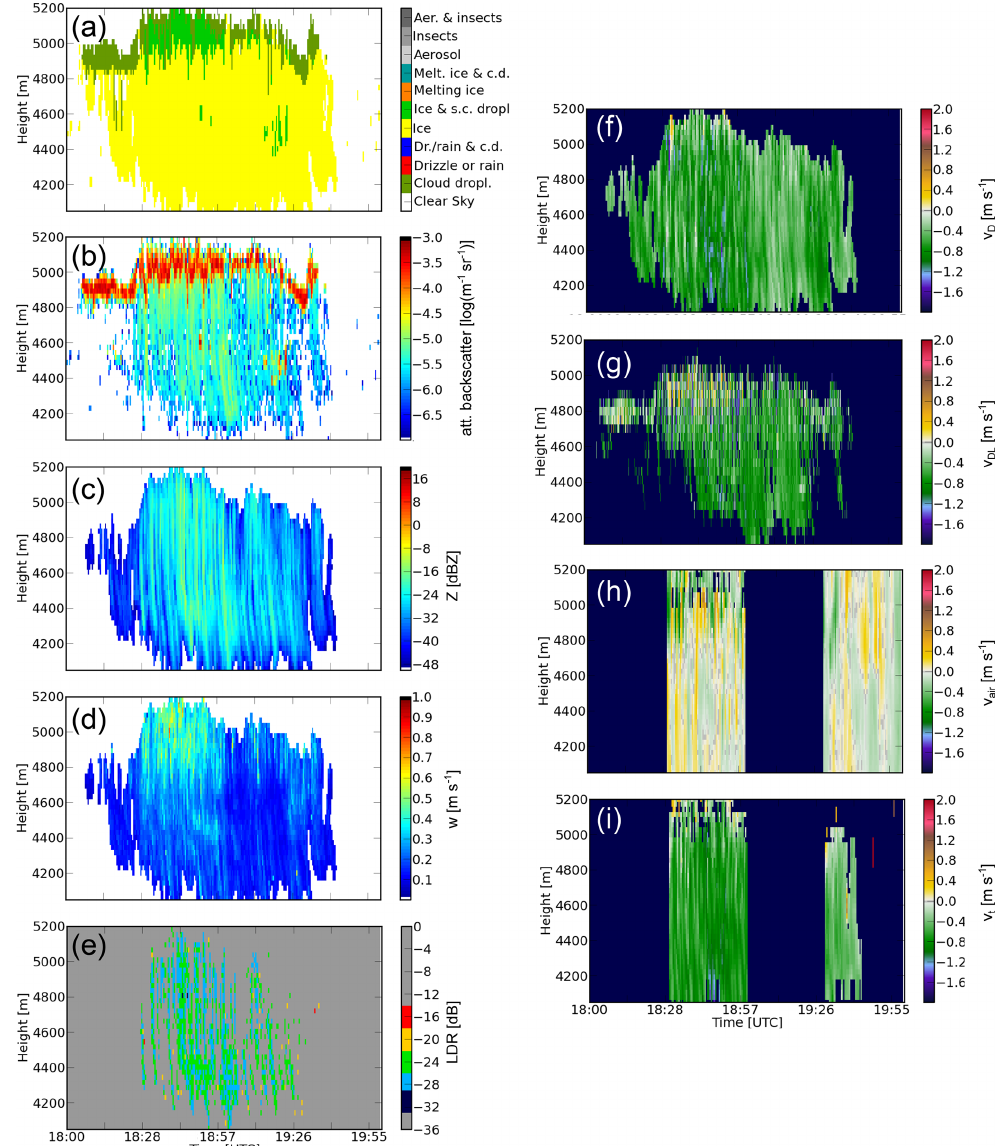
Figure 2. (a) Cloudnet target classification, (b) attenuated backscatter from lidar at the 1064nm wavelength, (c) CR reflectivity Z , (d) CR Doppler spectral width w , (e) CR linear depolarization ratio (LDR), (f) CR Doppler velocity v D , (g) Doppler lidar Doppler velocity v DL , (h) vertical air motions as measured with the RWP v air and (i) reflectivity-weighted terminal fall velocity v t are shown for a mixed-phase cloud layer observed on 11 June 2015 at Lindenberg. v t and v air are only available in 30min intervals because vertical and horizontal wind measurement modes of the RWP alternate every